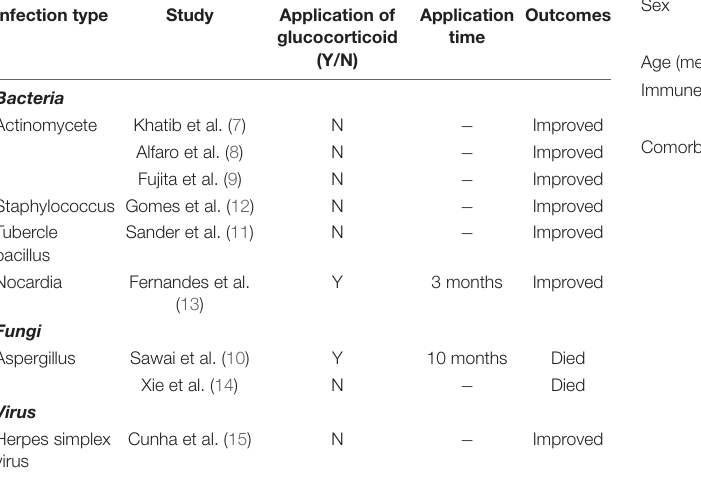
TABLE 2 | Nine cases of fungal, bacterial, and viral infections in patients with COP